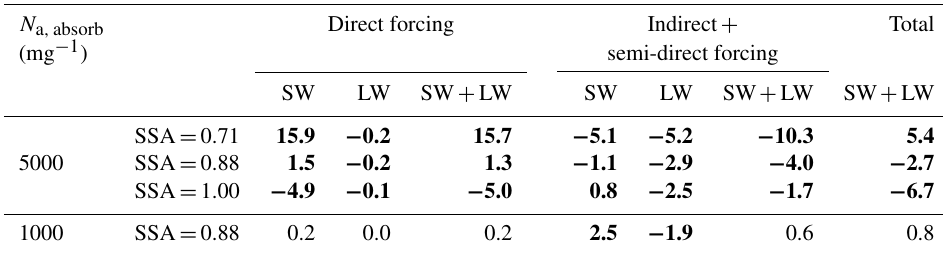
Table A1. As in Table 2 but for absorbing aerosol with different values of single scattering albedo (SSA), and only showing averages over the 3-day transition. For the last case the aerosol loading is reduced